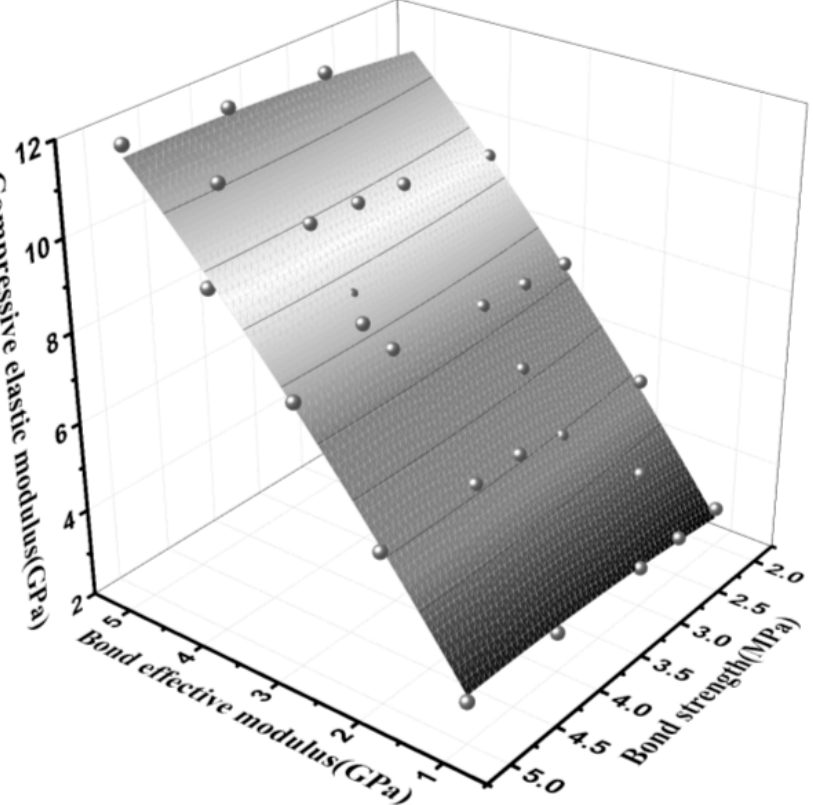
Figure 17. Relationship between bond effective modulus, bond strength and compressive elastic